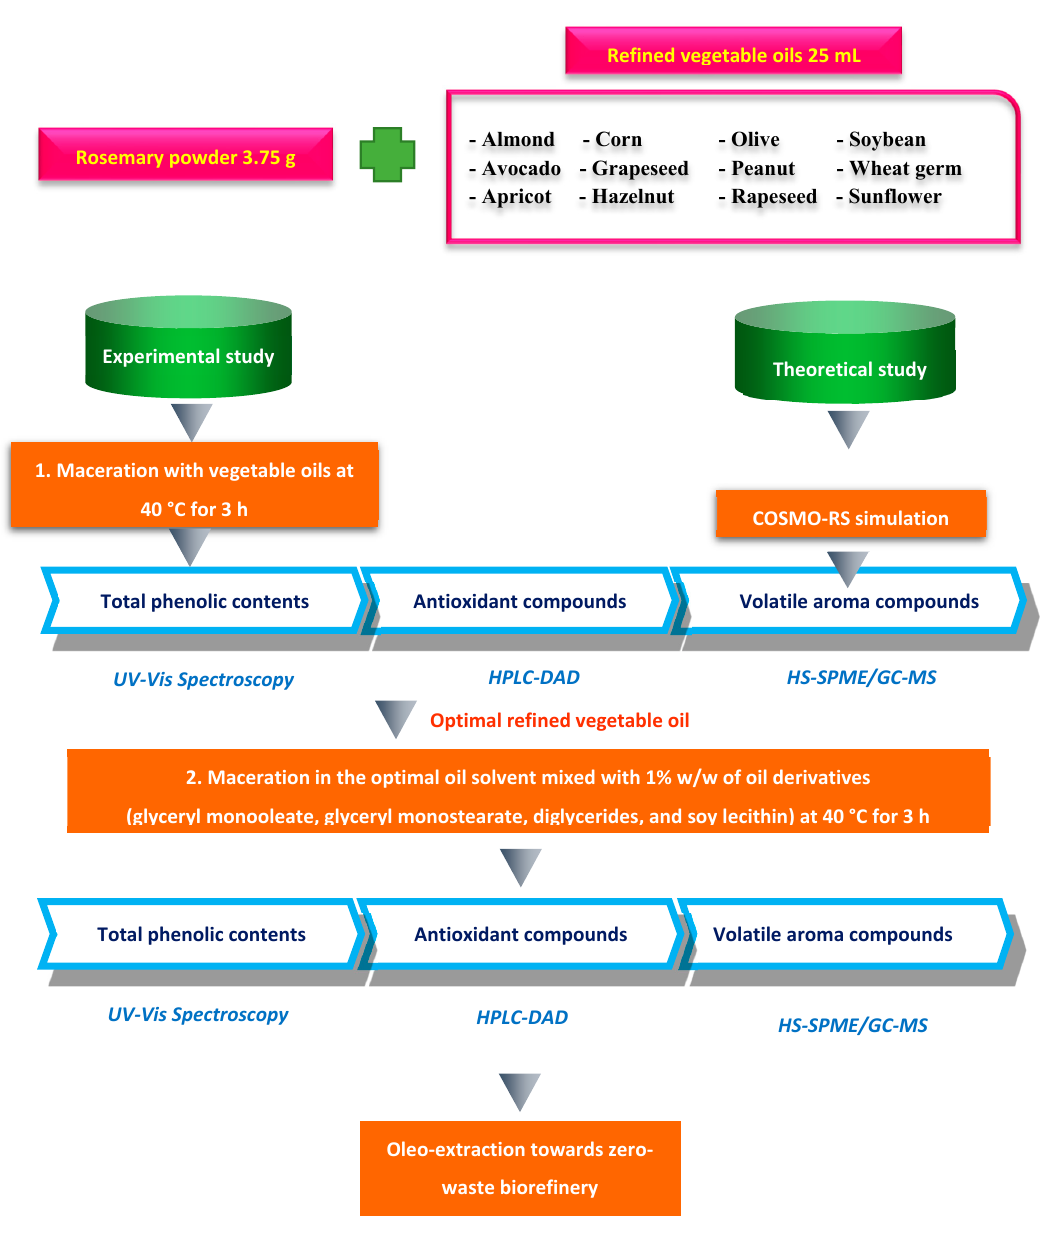
Figure 1. Schematic experimental design. UV-Vis: Ultraviolet-visible; HPLC-DAD: High performance